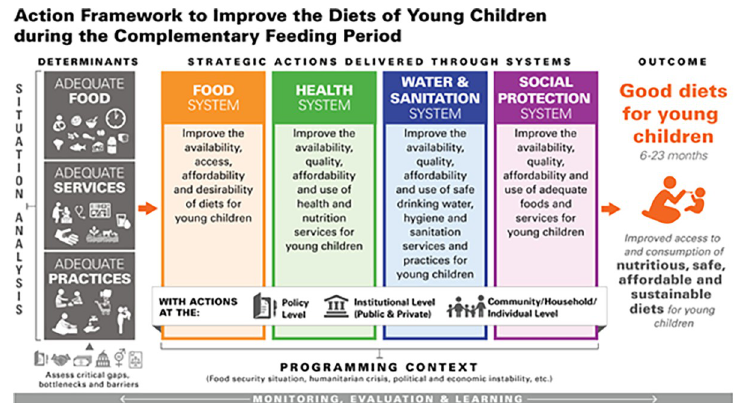
Fig 1. The UNICEF action framework to improve the diets of young children during the complementary feeding period. Source: UNICEF [11].